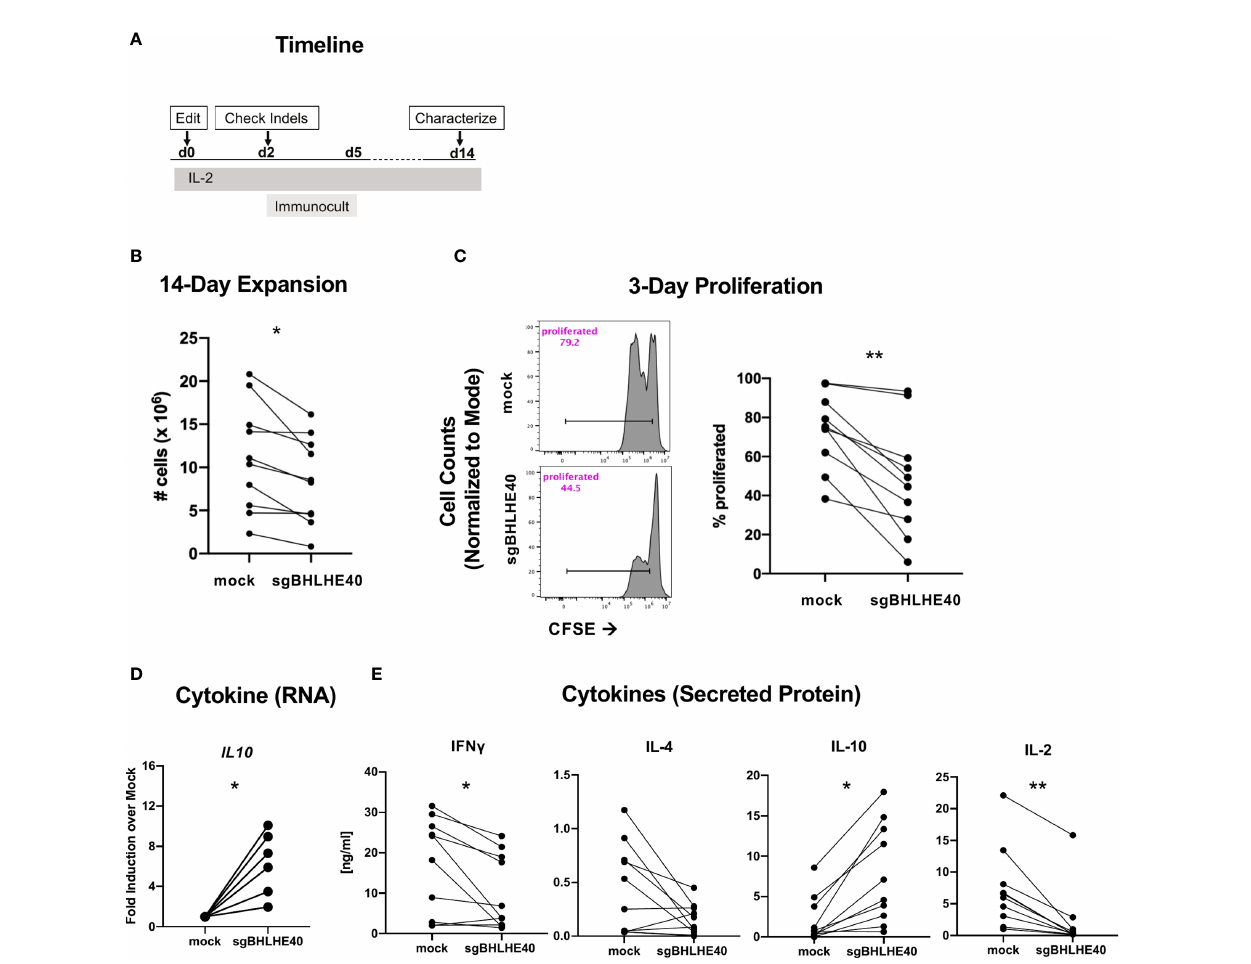
FIGURE 4 | BHLHE40 de fi ciency increases IL-10 in naïve CD4 + T cells. (A) Timeline of generating BHLHE40-edited CD4 + T cells. (B) In vitro expansion of mock- treated and sgBHLHE40-edited naïve CD4 + T cells. Cells were collected and counted with an automated cell counter after 2, 14-day expansions with Immunocult. n = 15. (C) Representative fl ow cytometry histogram of CFSE dilution 3 days post a CD3/ a CD28 Dynabead stimulation. Gated on live singlets (left). Cumulative CFSE proliferation data of all samples (right). (D) Cytokine gene expression. IL10 expression 6 hours after stimulation with a CD3/ a CD28 Dynabeads. Expression is normalized to the house keeping gene, RPLPO . n = 6. (E) T cells were stimulated with plate-bound a CD3 and soluble a CD28, and supernatant was collected at 24h (IL-2) and 48h (IFN- g , IL-4, IL-10) to measure cytokines by ELISA. n = 10, *p value < 0.05, **p value < 0.01, Wilcoxon matched-pairs signed rank